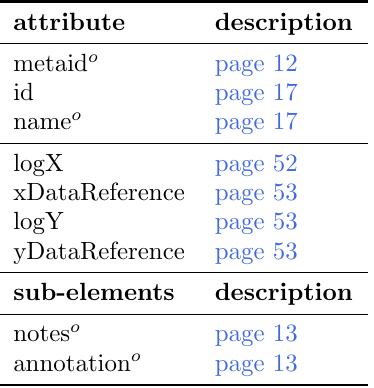
Table 2.25: Attributes and nested elements for curve. o denotes optional elements and attributes.